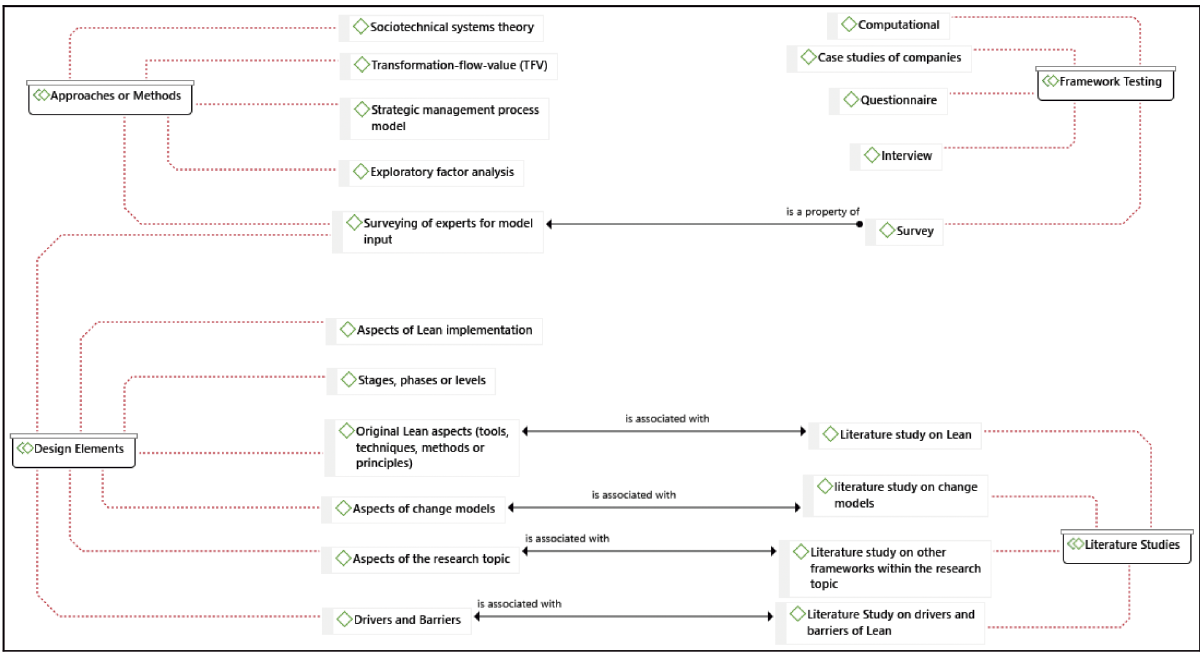
Figure 2. Network model generated in Atlas